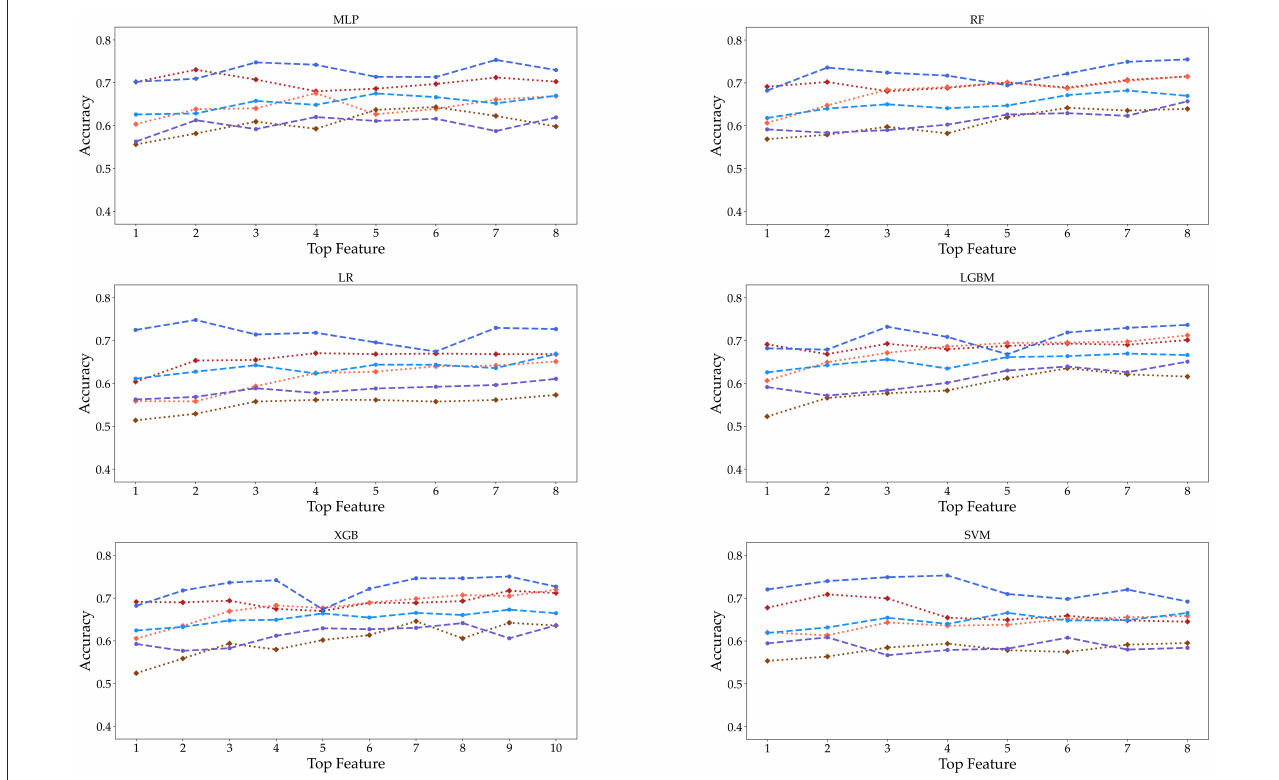
FIGURE6 Accuracy is displayed as the number of features from 1 to 8 under three age groups and two genders. These features are extracted from the RF feature importance and mean absolute SHAP values in Figure